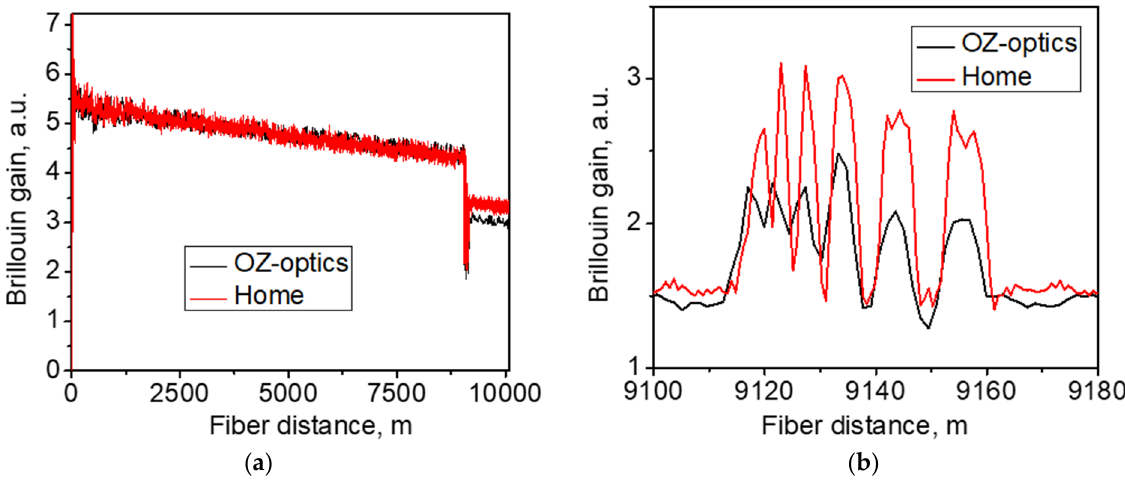
Figure 5. The measured distribution of the Brillouin gain ( a ) over the whole testing line and ( b ) over the range of 9.1–9.18 km.